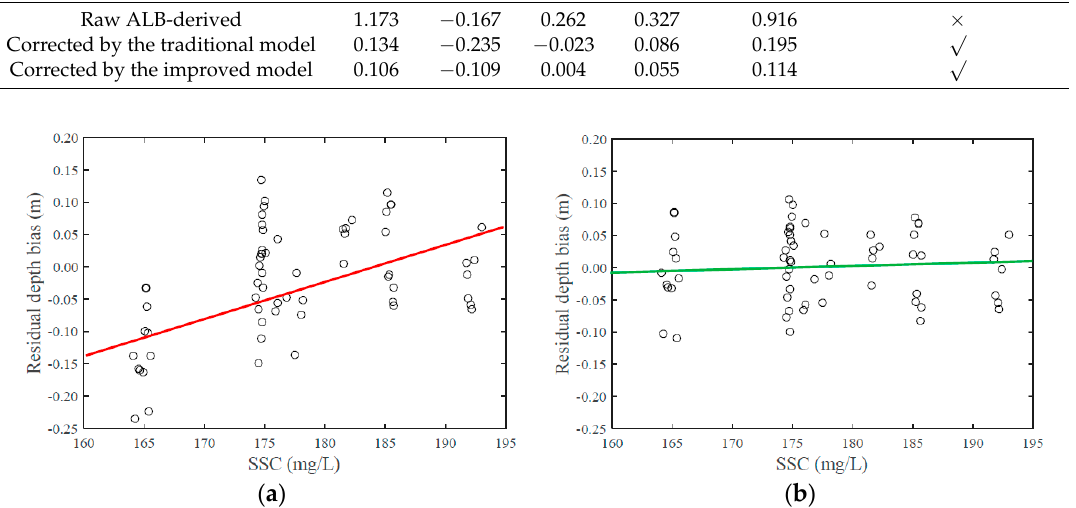
Figure 5. Distributions of depth bias corrected by the ( a ) traditional and ( b ) improved models varying with SSC.